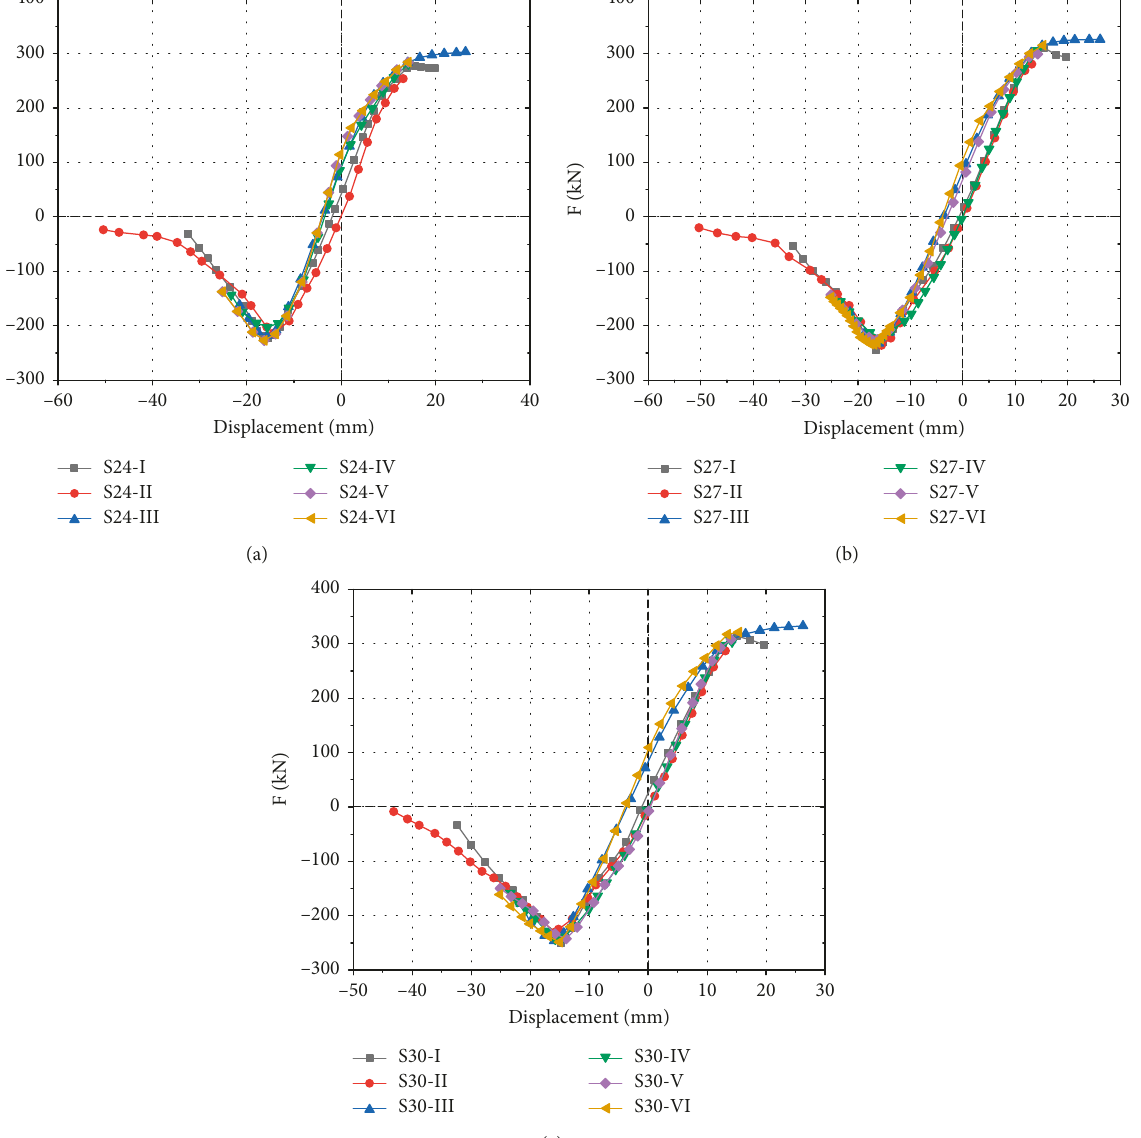
Figure 14: Comparison of skeleton curves. (a) Skeleton curves of S24. (b) Skeleton curves of S27. (c) Skeleton curves of